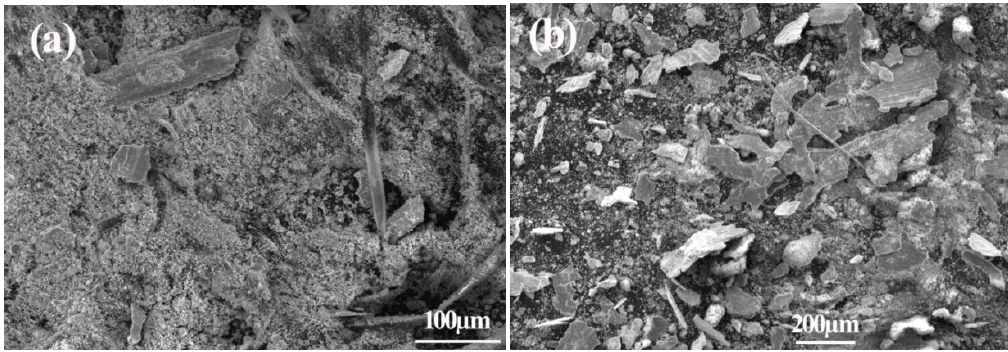
Figure 7. SEM micrographs showing the wear debris of ( a ) the Ni–Mo–Si ternary intermetallic composite and ( b ) hardened 1.0% C–1.5% Cr bearing steel under room temperature dry-sliding wear conditions.